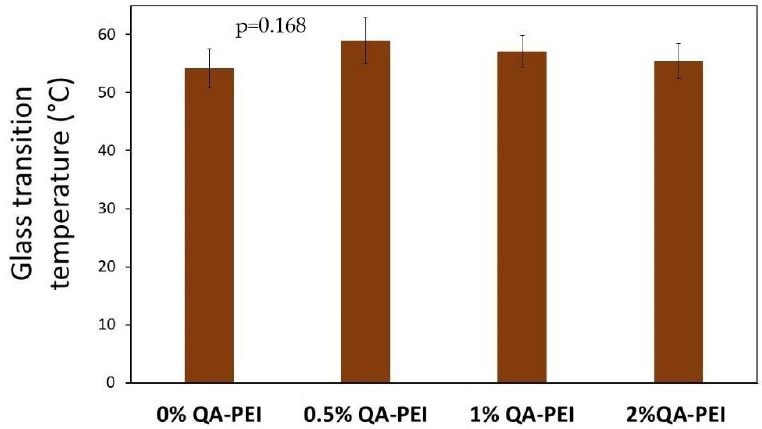
Figure 9. T g values of the materials. All the results for T g were statistically insignificant ( p > 0.05).